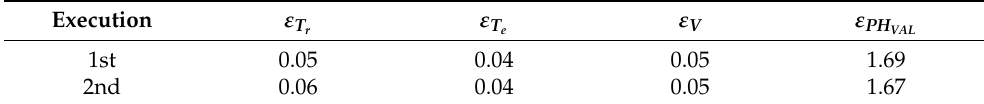
Figure 18. Histogram of the lags ’ usage in the non-dominated M 4 models: ( a ) P G ; ( b ) R ; ( c ) T. Table 5. Statistics for M 4